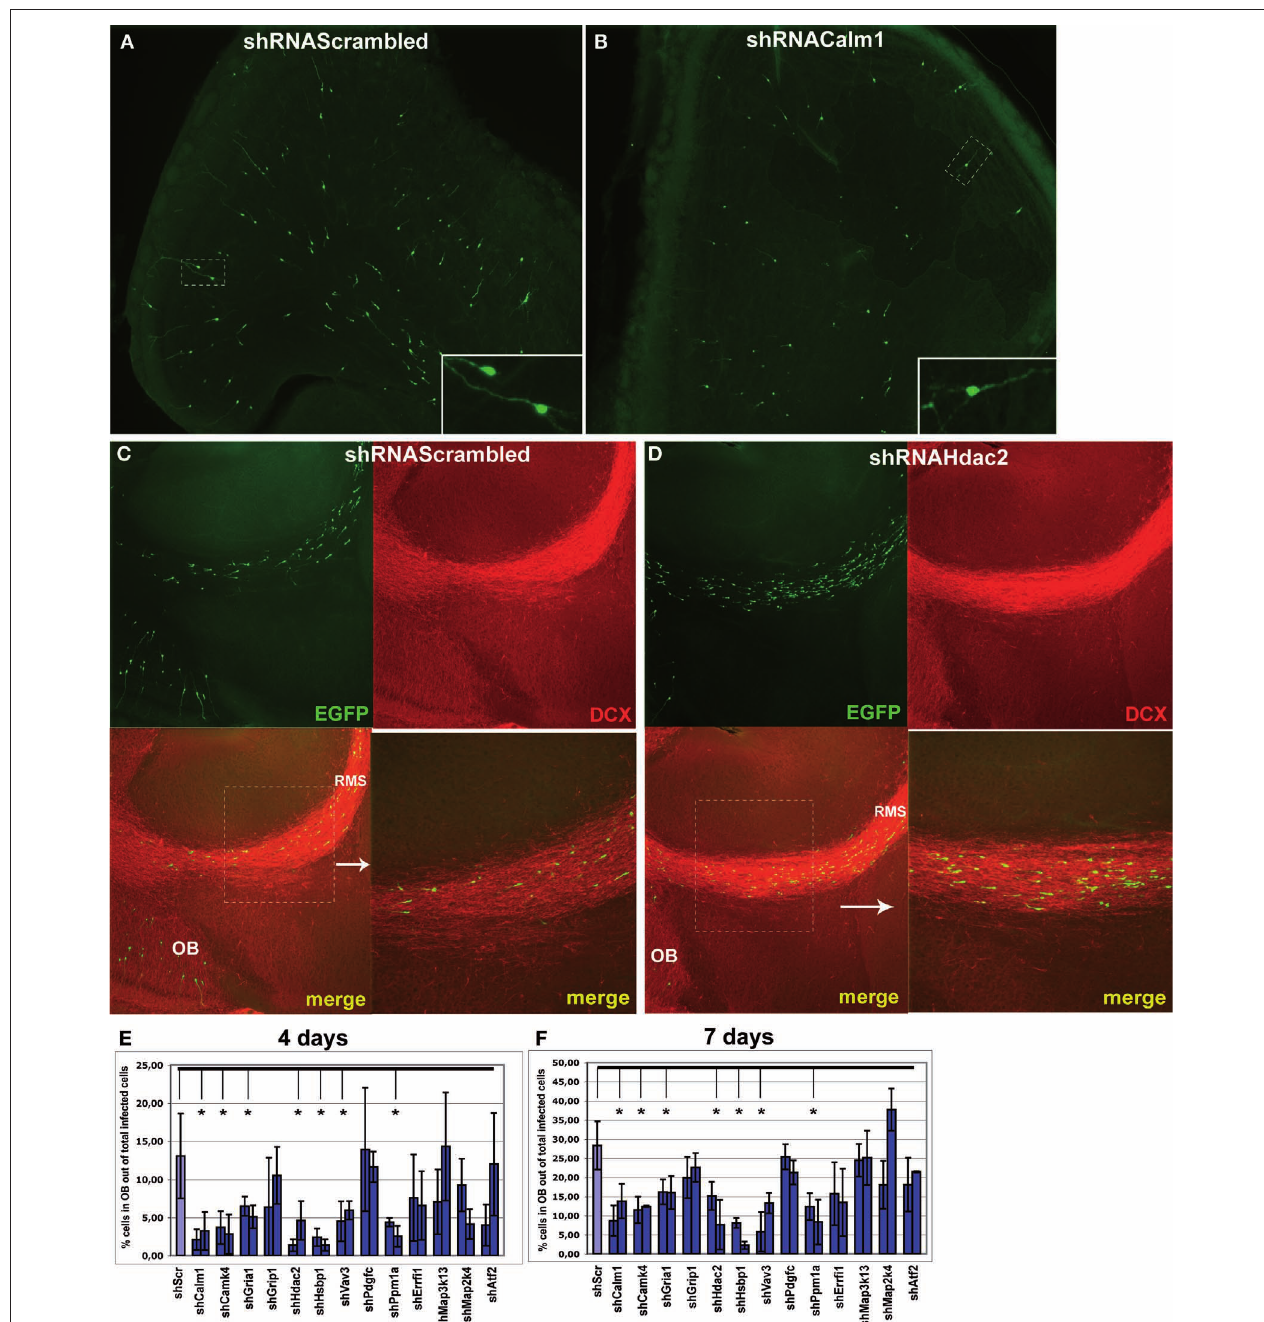
FIGURE 6 | Effect of in vivo gene expression knockdown on neuroblast migration to the olfactory bulb. (A) and (B) Example of gene knockdown effect. Green fl uorescent cells in olfactory bulb infected by shRNAScrambled and shRNACalm1 viruses, respectively. Insets show higher magnifi cation of cells indicated by boxed area. Much fewer shRNACalm1-expressing cells reached the OB after 7 days post-injection in comparison to cells infected with shRNAScrambled virus. (C) and (D) Effect of Hdac2 knockdown on neuroblast migration in the RMS. Compared to